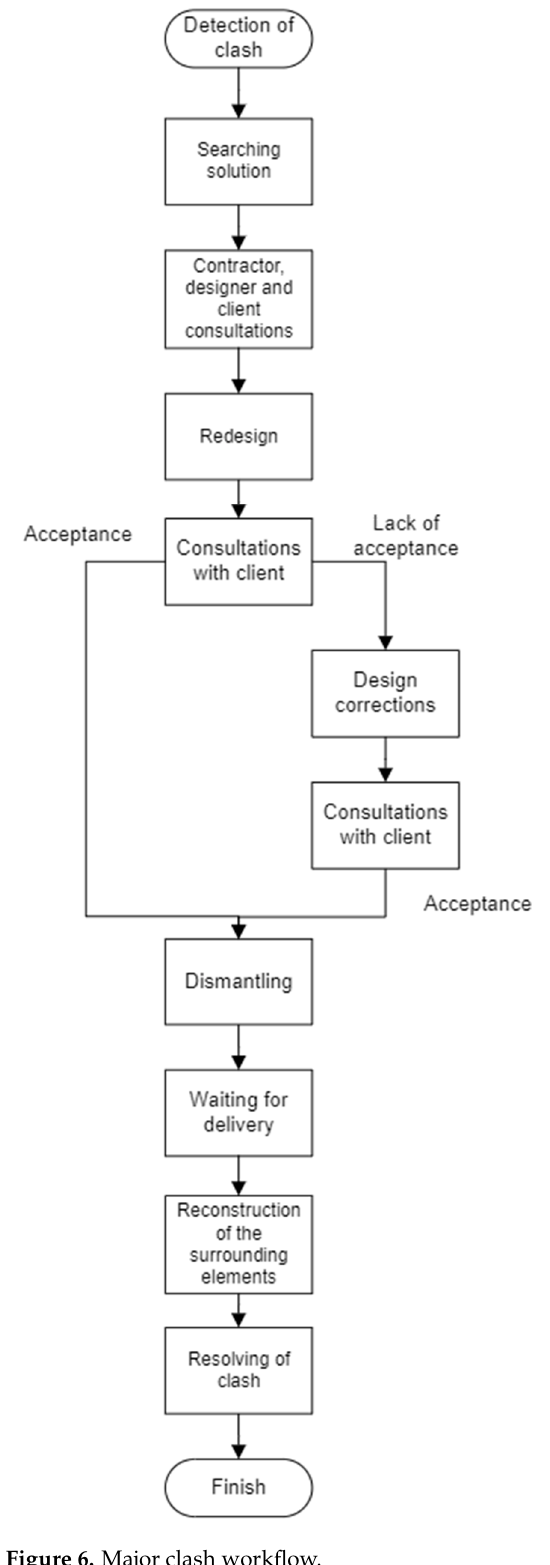
Figure 6. Major clash workflow.